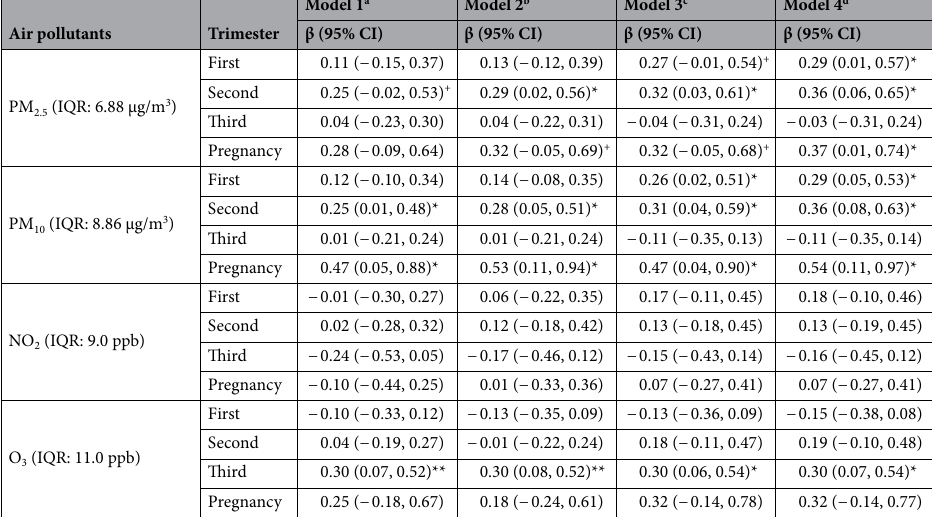
Table 3. Associations between air pollution exposure (per IQR increase) and PSS scores among pregnant women in single-pollutant models. CI confidence interval, IQR interquartile range, ppb parts per billion, PPS perceived stress scale. + p-value < 0.1. *p-value < 0.05. **p-value < 0.01. a Model 1: unadjusted. b Model 2: